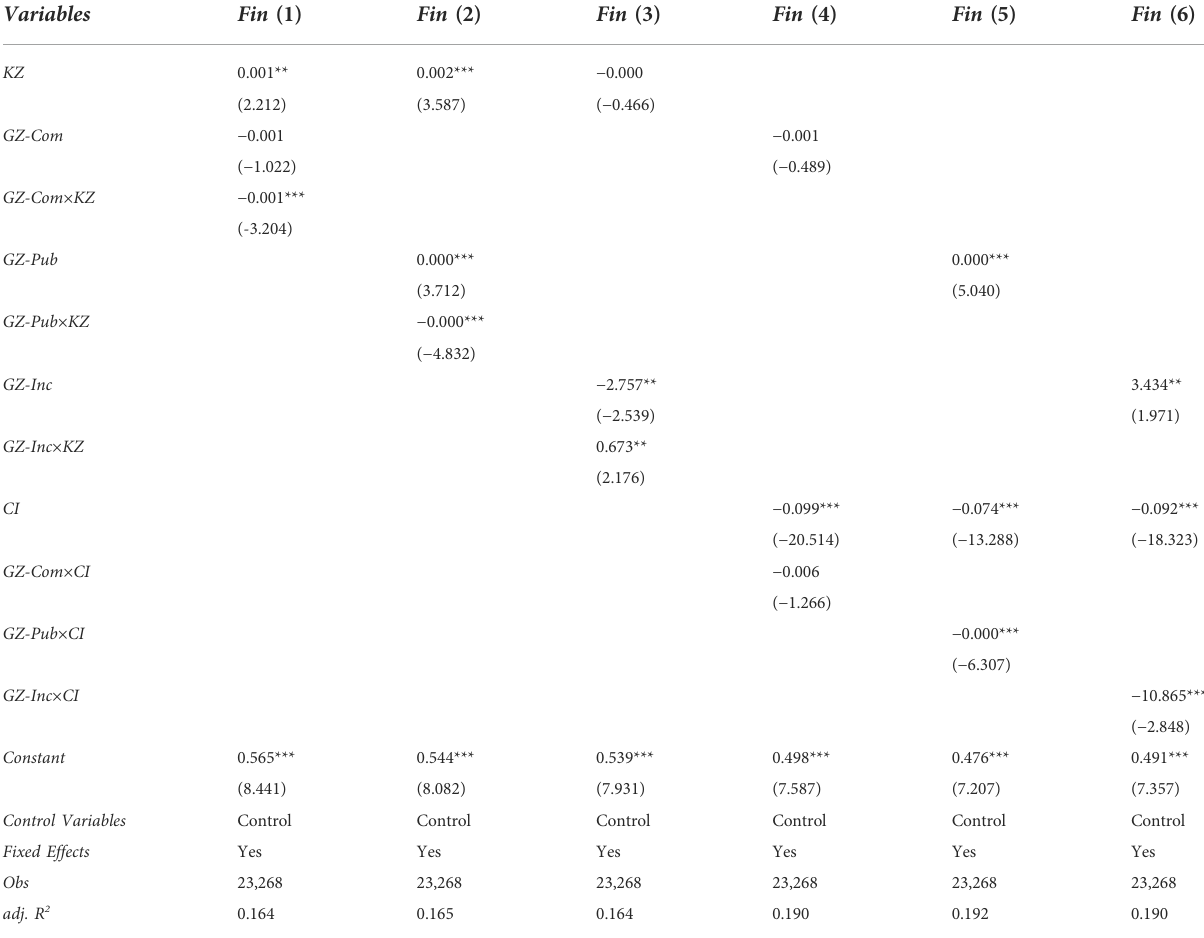
TABLE 8 Test of the moderating effect of fi nancing constraints and relocation